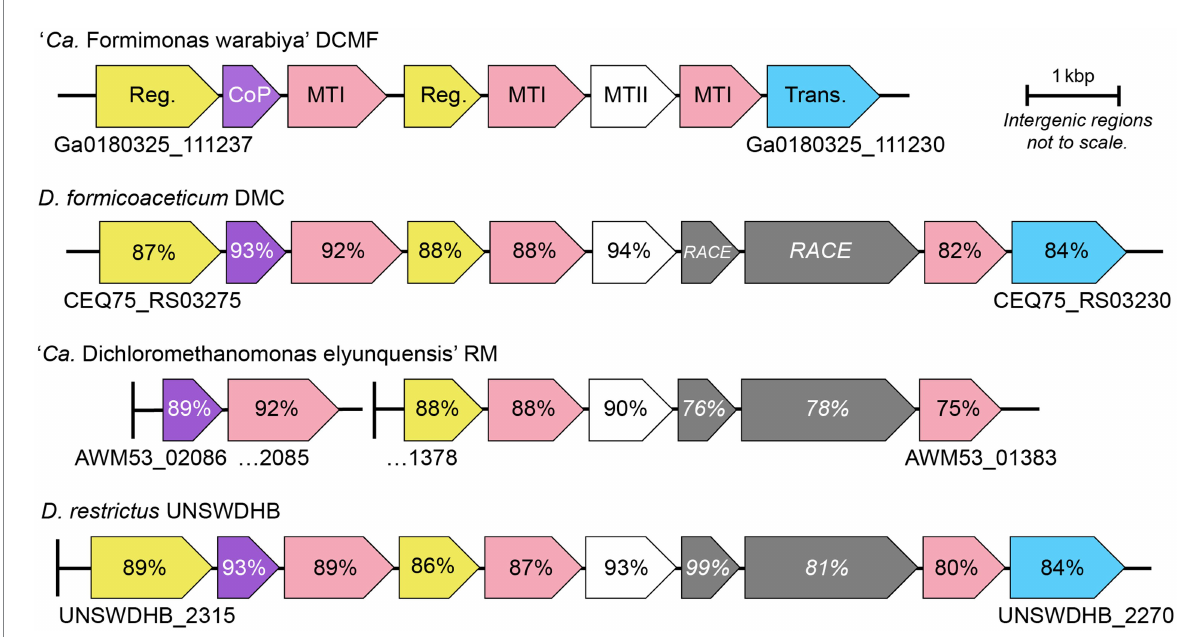
FIGURE 3 Genetic organization of the mec cassette in strain DCMF and other anaerobic chlorinated methane-degrading bacteria. Loci are shown below the first and last gene in each cluster. Percentage sequence identity to strain DCMF is shown for each homologous protein; percentage identity for the DUF proteins (italicized) is in relation to D. formicoaceticum . Vertical lines represent contig boundaries. Reg, regulator; CoP, corrinoid protein; MTI, methyltransferase I; MTII, methyltransferase II; Trans, transporter; RACE, reductive activator of corrinoid-dependent